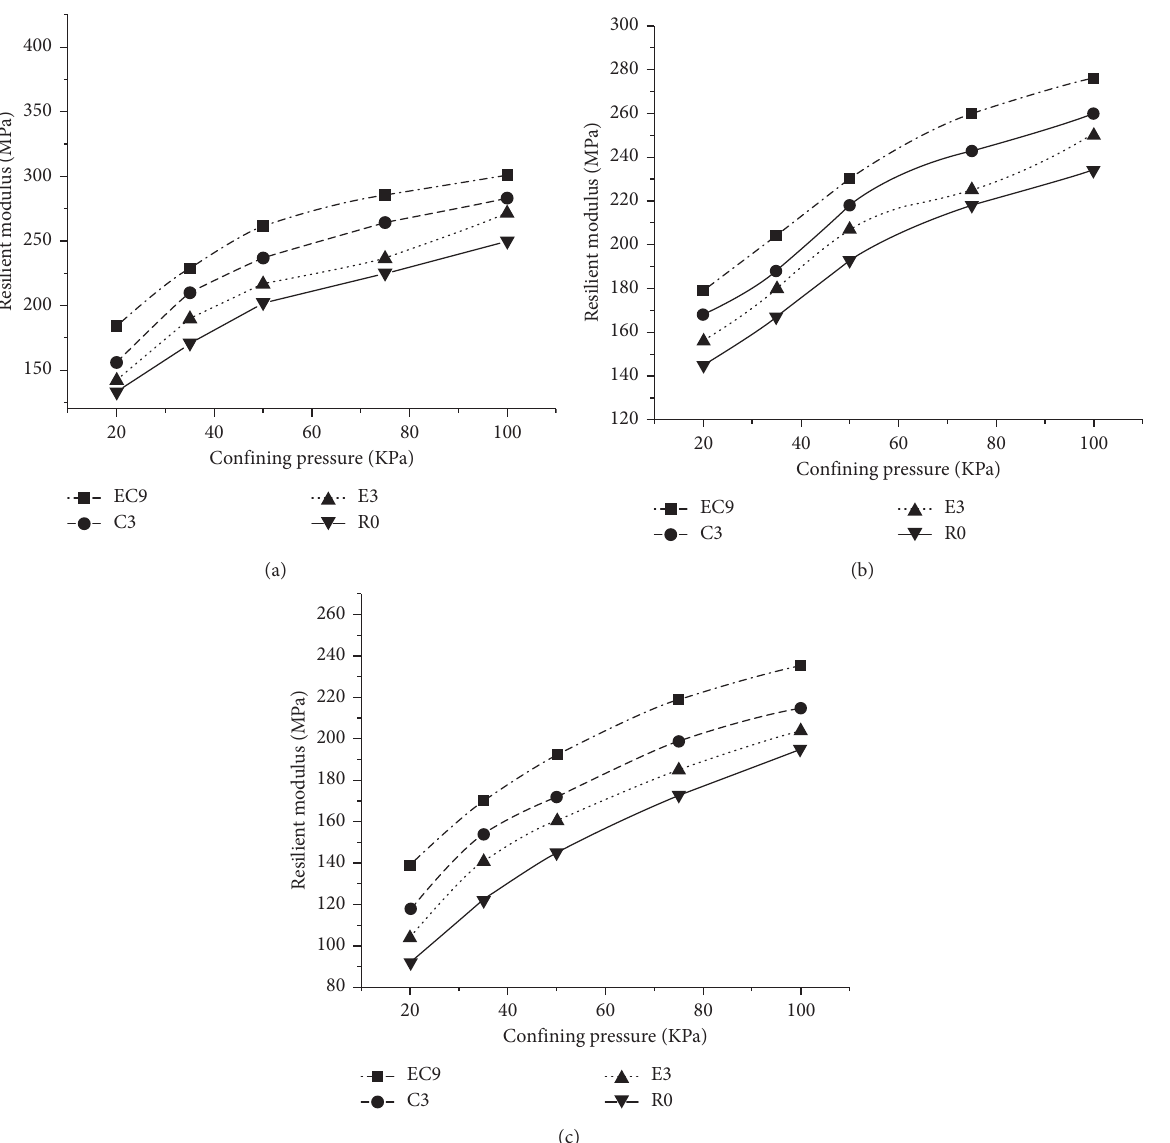
Figure 7: Relationship of confining pressure, degree of compaction, and resilient modulus. (a) 100% DOC, (b) 95% DOC, and (c) 100% DOC.